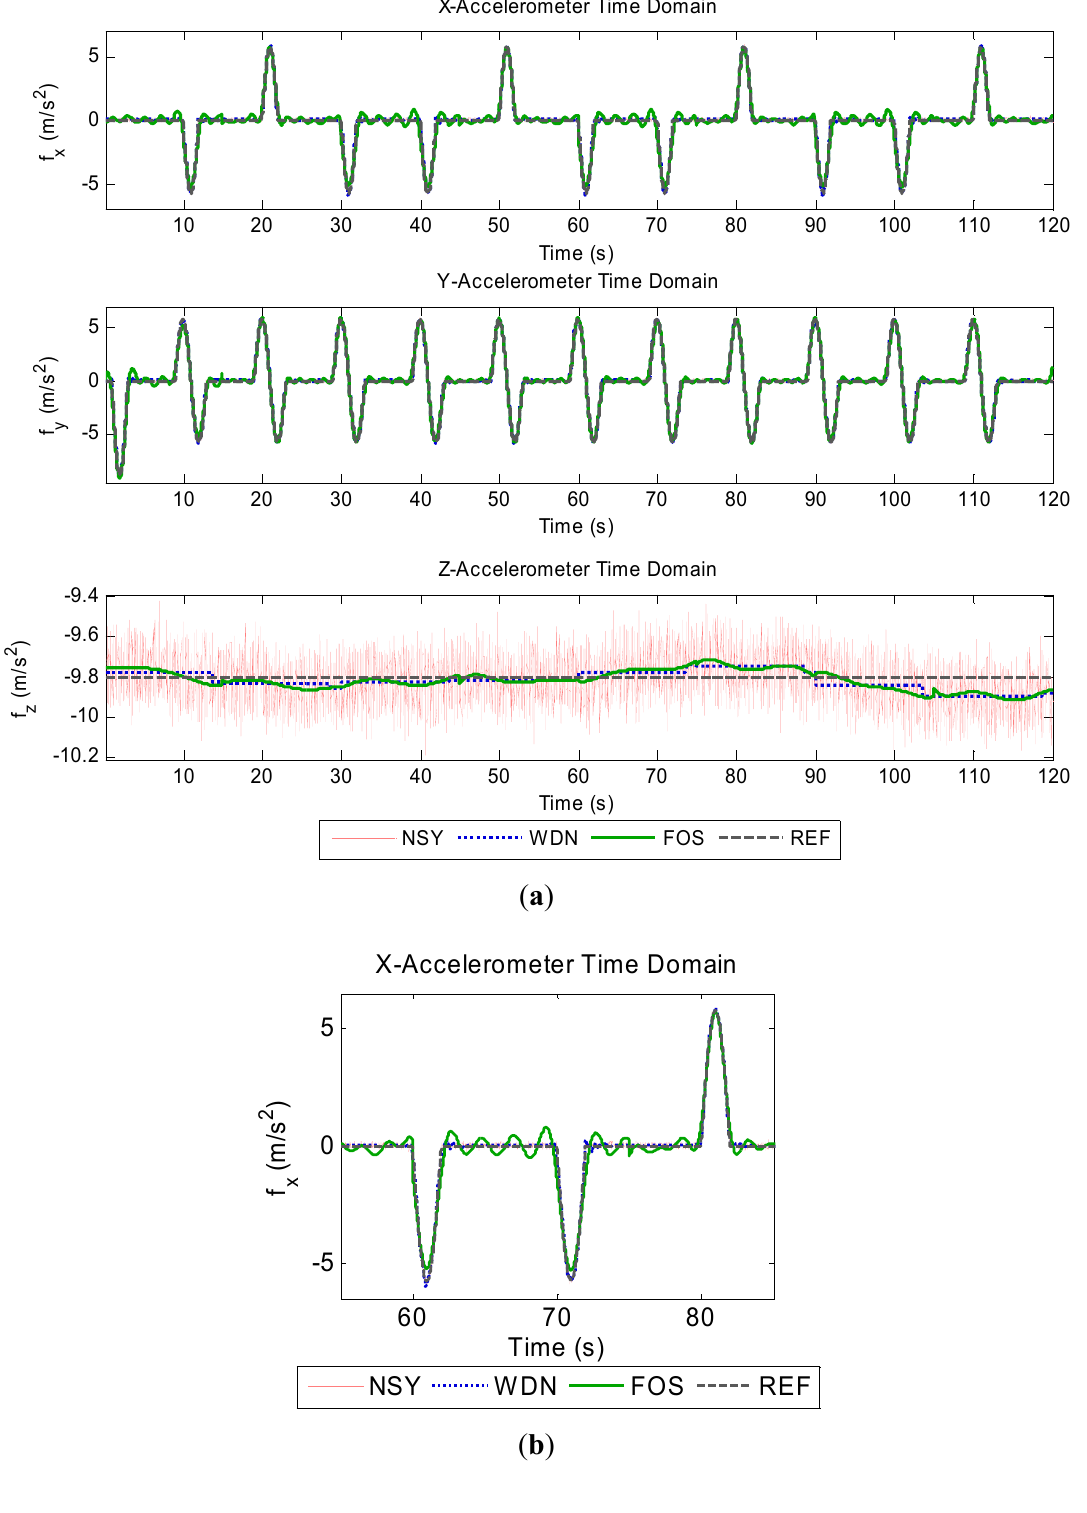
Figure 3. Accuracy enhanced accelerometer signals. ( a ) Accelerometer signals. ( b ) Zoomed-in section of x-acc illustrating